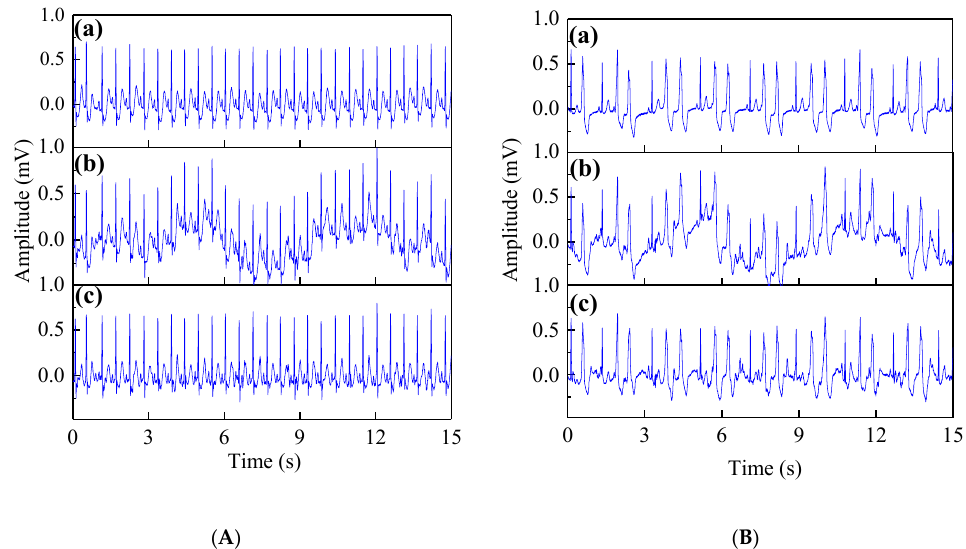
Figure 5. ( A ) The denoising results of the EWT-WT motion artifact removal method on normal beat record 213.